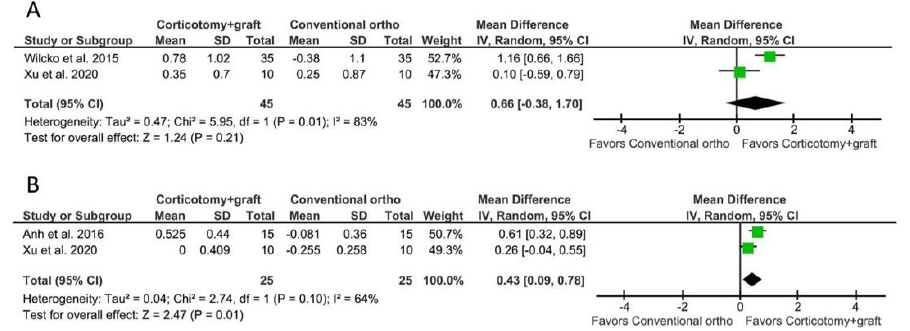
Figure 3. Meta-analyses for the outcomes of PAOO compared to a conventional orthodontic treatment. ( A ) For the gain of keratinized tissue width, the WMD was 0.66 mm (95% CI = − 0.38–1.70 mm, p = 0.21), representing no statistically significant difference between the groups. ( B ) For the gain of bone thickness, the WMD was 0.43 mm (95% CI = 0.09 – 0.78 mm, p = 0.01), favoring the PAOO group.